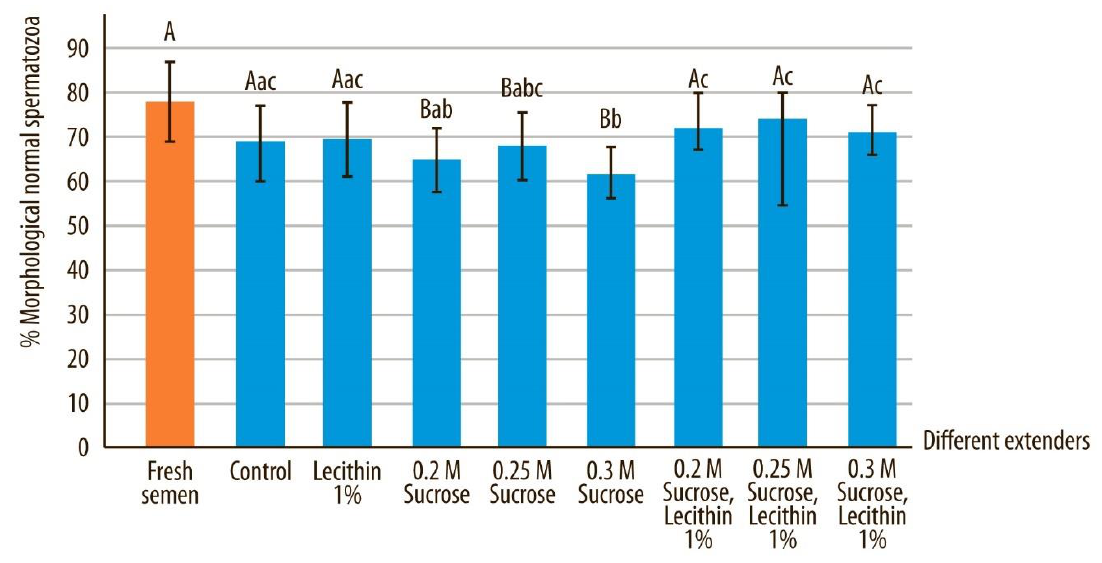
Figure 5. Normal morphology in canine sperm after devitrification regarding different vitrification media. Data are expressed as mean ± SD.